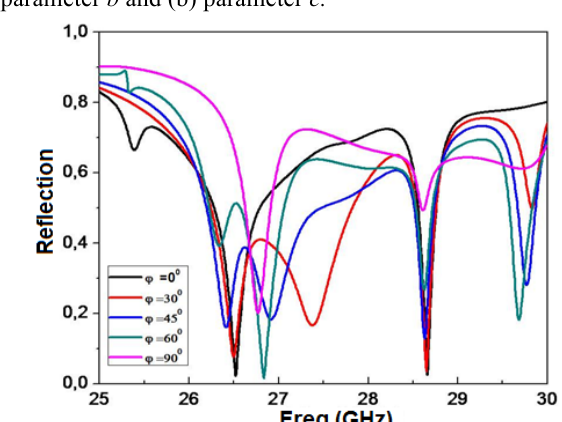
Figure 5: The dependence of absorption frequency on